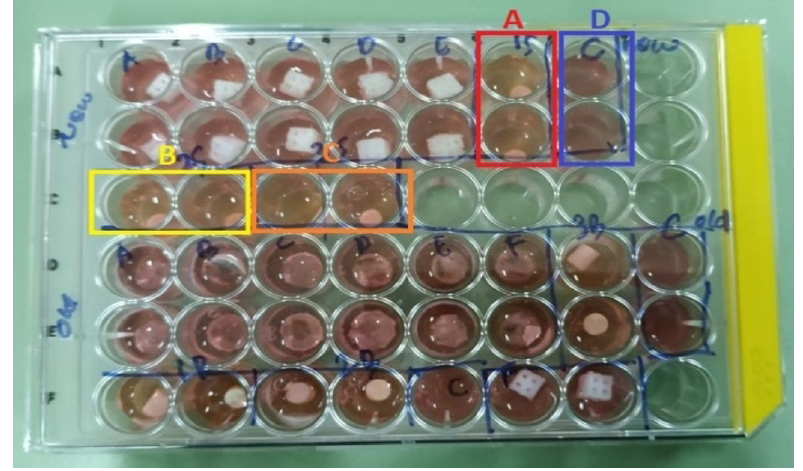
Figure 2: Incubation of collagen - composite